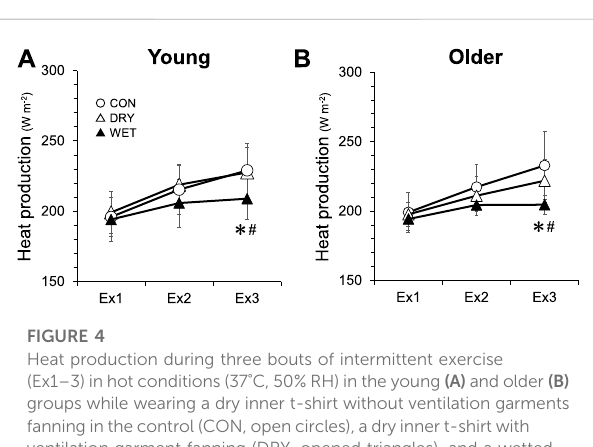
FIGURE 4 Heat production during three bouts of intermittent exercise (Ex1 – 3) in hot conditions (37 ° C, 50% RH) in the young (A) and older (B) groups while wearing a dry inner t-shirt without ventilation garments fanning in thecontrol (CON, open circles),a dry inner t-shirt with ventilation garment fanning (DRY, opened triangles), and a wetted inner t-shirt with ventilation garment fanning (WET, closed triangles). *Signi fi cantly different for CON vs. WET trial, p < 0.05. #Signi fi cantly different for DRY vs. WET trial, p < 0.05. Data are expressed as the mean ± SD for eight